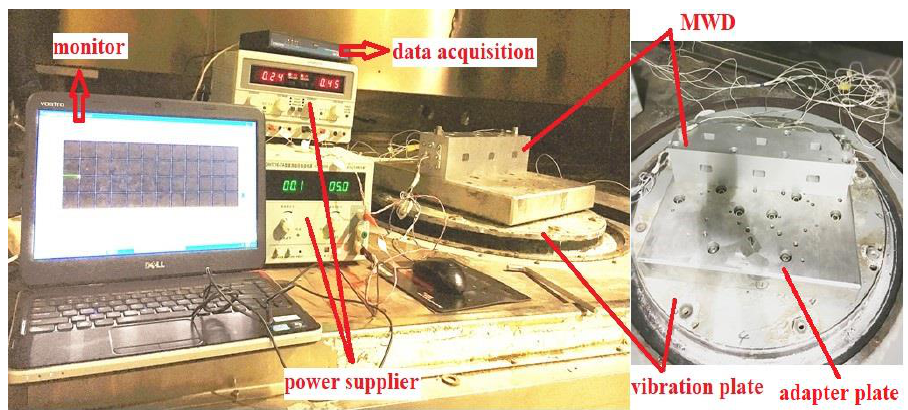
Figure 13. Vibration experimental set-up.